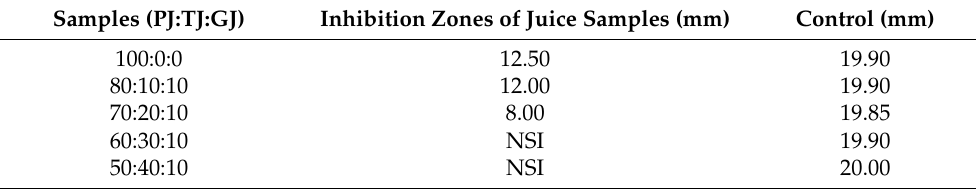
Table 6. Antimicrobial inhibition of Ginger, Pineapple, and Tumeric Juice Mix as influenced by Blends. Samples (PJ:TJ:GJ) Inhibition Zones of Juice Samples (mm) Control (mm) 100:0:0 12.50 19.90 80:10:10 12.00 19.90 70:20:10 8.00 19.85 60:30:10 NSI 19.90